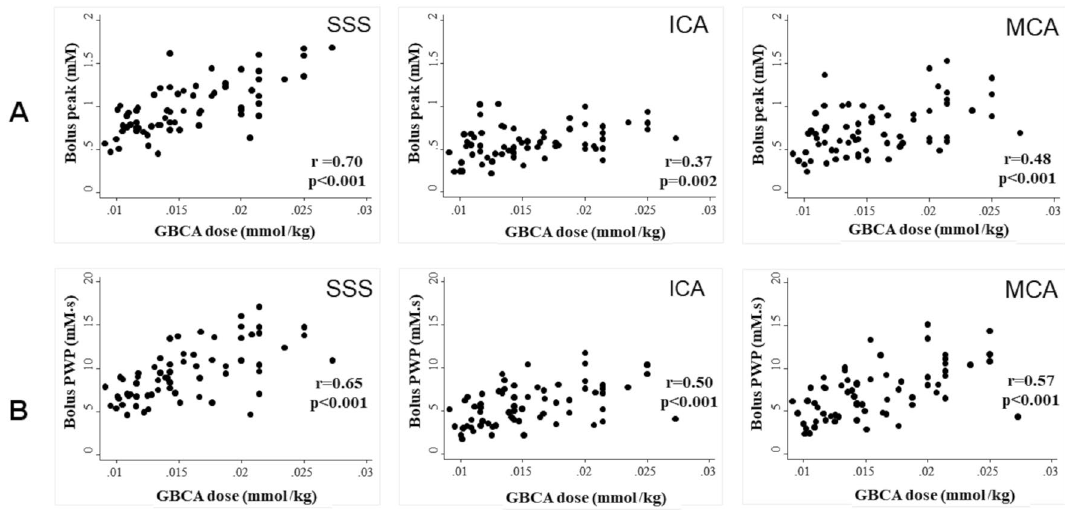
Figure 4. Relationship between extracted VOF/VIF features and administered GBCA dose for VOF SSS , VIF MCA and VIF ICA . Top row: Scatter plots of bolus-peak (mM) vs administered GBCA dose (mmol/kg). Bottom row: Scatter plots of GBCA bolus peak∙FWHM product (PWP, mM ⋅ s) vs administered GBCA dose. Pearson’s product moment correlation coefficient (r) shown with associated p value. FWHM = full-width at half-maximum; ICA = Internal carotid artery; MCA = Middle cerebral artery; PWP = bolus peak∙FWHM product; SSS = Superior sagittal sinus.